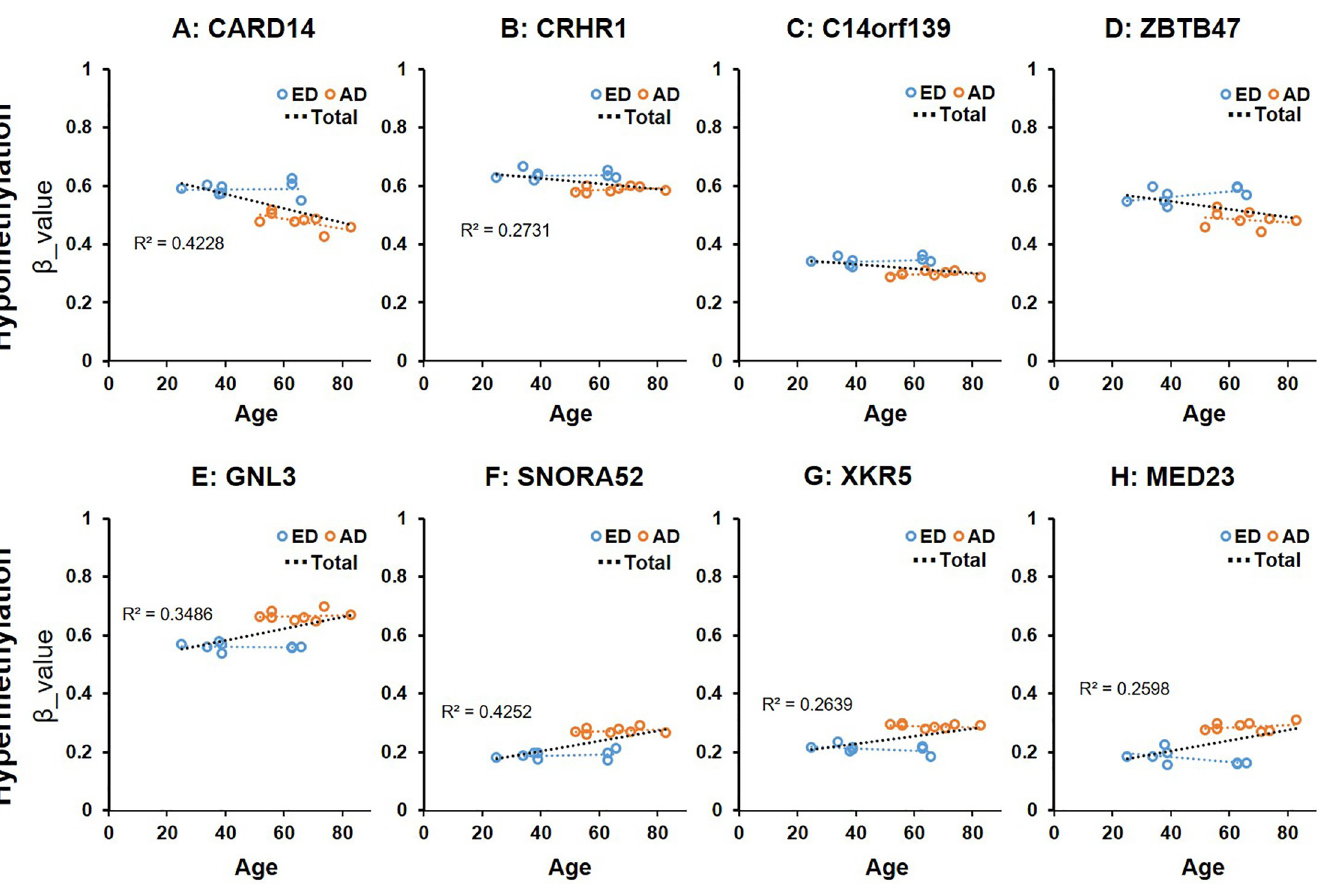
Fig 5. Scatter plots of the β value of four highest hypomethylated and hypermethylated loci between early stage (ED) and advanced stage (AD) of degeneration according to age. Blue dots indicate the β values of the early stage of degenerated (ED) samples, and orange dots indicate β values of the advanced stage of degenerated (AD) samples. R2: correlation coefficient. � P < 0.05, �� P < 0.01. A: CARD14 (Caspase Recruitment Domain Family Member 14), B: CRHR1 (Corticotropin Releasing Hormone Receptor 1), C: C14orf139 (Chromosome 14 Open Reading Frame 139), D: ZBTB47 (Zinc Finger And BTB Domain Containing 47), E: GNL3 (G Protein